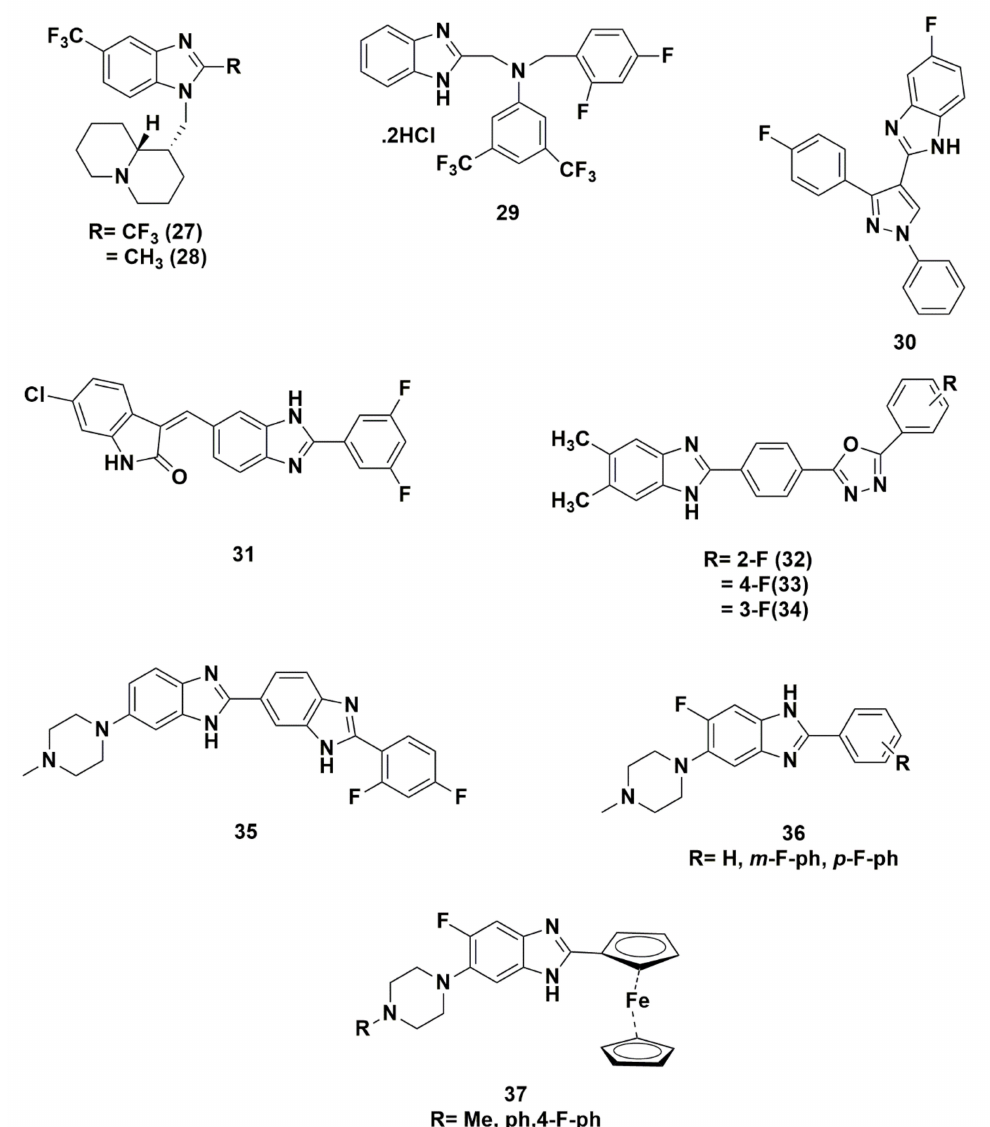
Figure 8. Benzimidazole derivatives incorporating